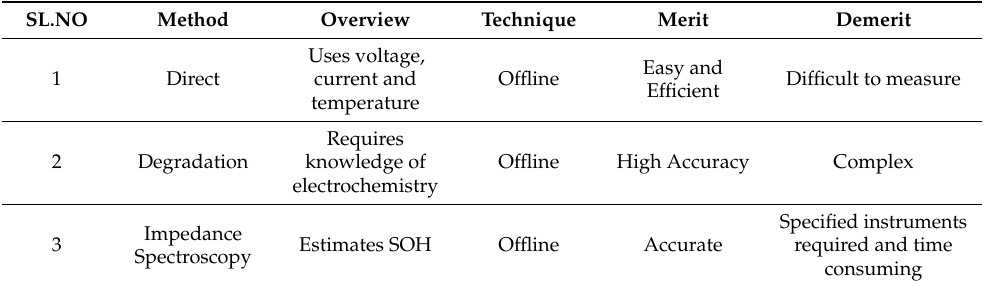
Table 2. Direct methods Vs. Degradation